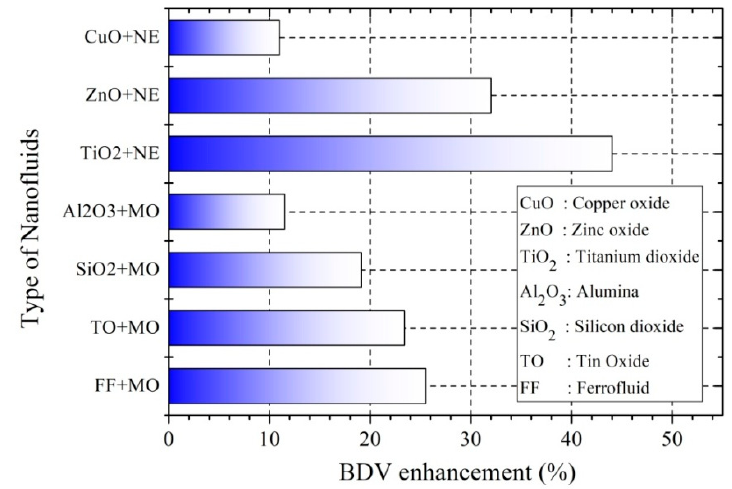
Figure 1. Reports on the breakdown voltage performance of nanofluids